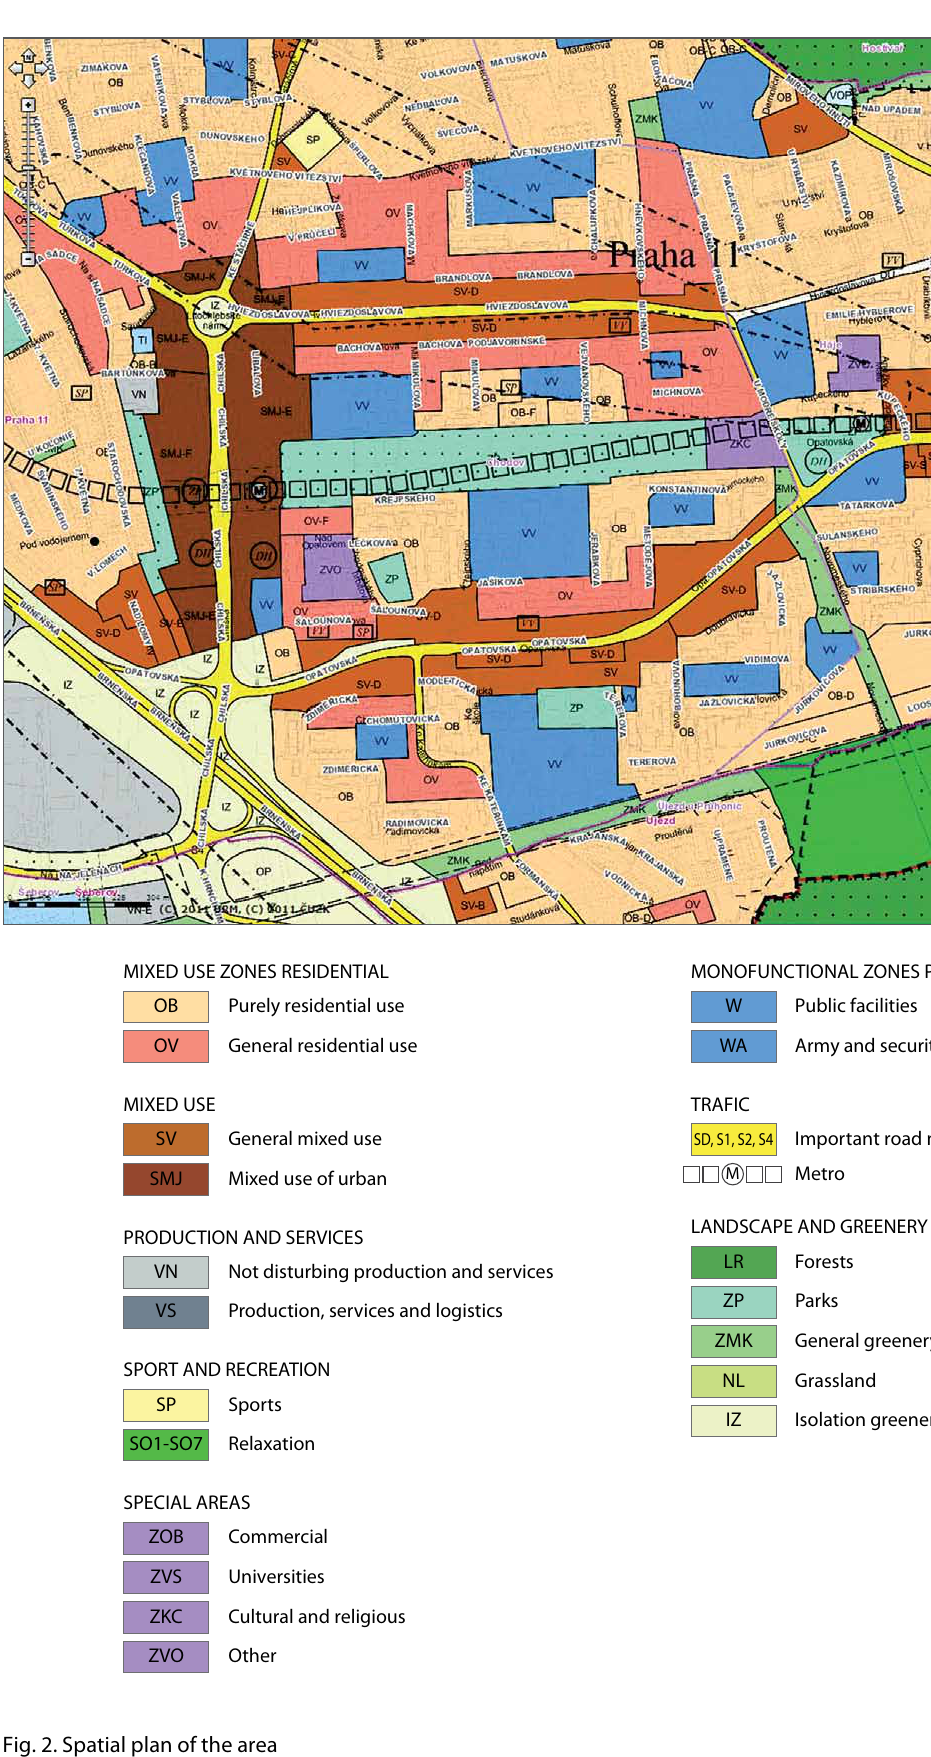
fig. 2. Spatial plan of the area